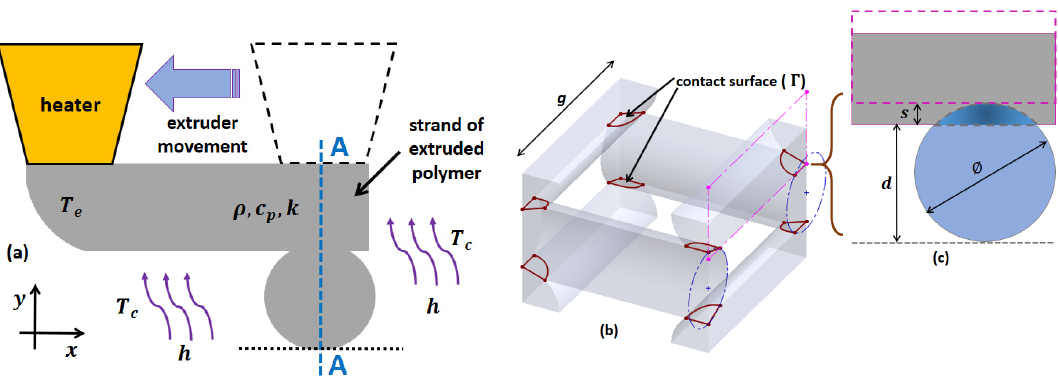
Figure 2. The model considered in the analysis of self-adhesion: ( a ) 2D representation of fused deposition; ( b ) unit cell considered as fundamental part of the scaffolds; and ( c ) 2D model considered for